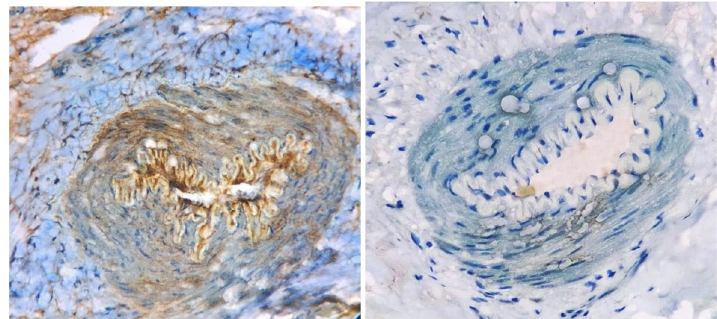
Fig. 2 A case of vasomotor rhinitis pre- and post-treatment with immunohistochemical staining show staining of arteries grade 3 to grade 0